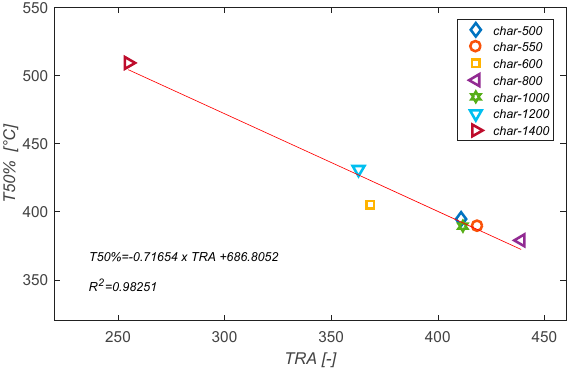
Figure 12. Evolution of T ( 50% ) with the TRA.